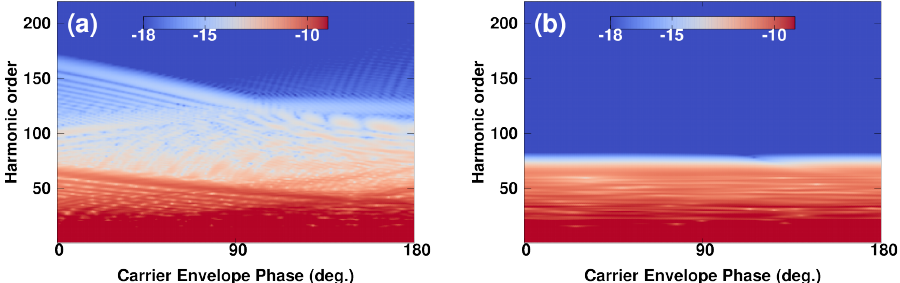
Figure 4. (Color online). 1D—calculations of the harmonic spectra as a function of the relative optical phase between the NIR and IR pulses. ( a ) In the presence of the assisting IR pulse and ( b ) in the absence case. The parameters of the NIR pulse are: λ NIR = 1.27 µ m, T c = 10 cycles and I NIR = 1 × 10 14 W/cm 2 . The parameters of the IR pulse are: λ IR = 12.7 µ m and I IR = 1 × 10 13 W/cm 2